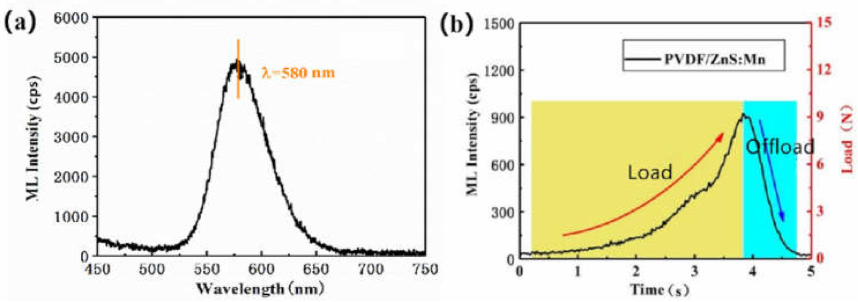
Figure 7. ( a ) ML spectrum of PVDF/ZnS:Mn composite film sensor and ( b ) ML intensity of PVDF/ZnS:Mn composite film sensor varies with the load.